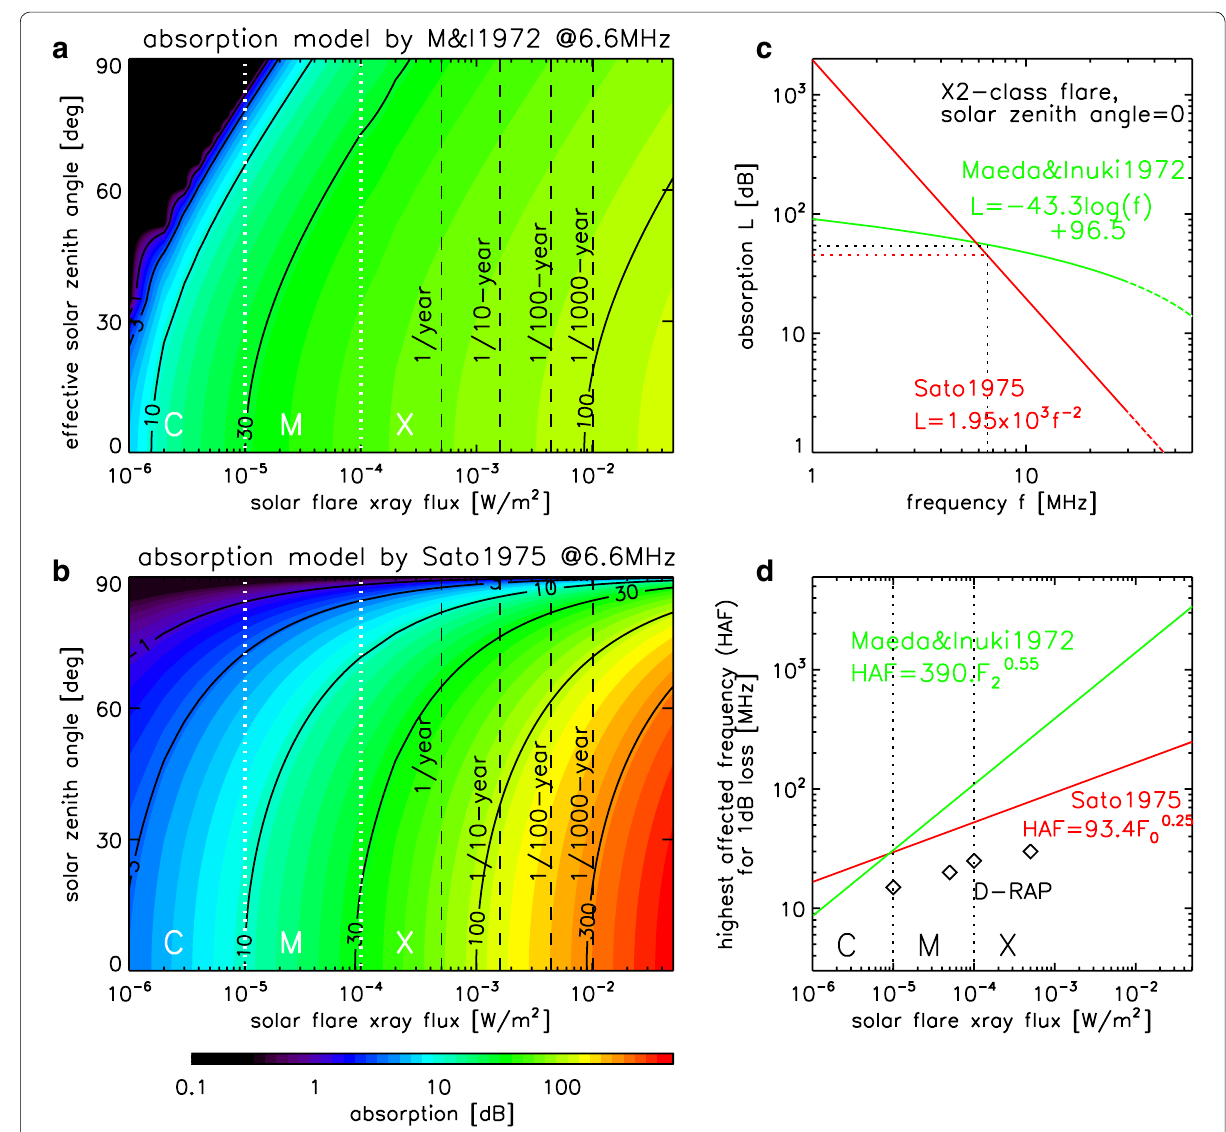
Fig. 9 Absorption intensity in dB at 6.6 MHz as a function of solar flare X-ray flux and (effective) solar zenith angle obtained using a Eq. (10) from Maeda and Inuki (1972) and b Eq. (2) from Sato (1975) with a common color contour shown by the color bar at the bottom, c absorption intensity for X2-class flare and solar zenith angle of 0° as a function of signal frequency, and d highest affected frequency (HAF) as a function of solar flare X-ray flux. In c, d, the absorption intensity from Maeda and Inuki (1972) and that from Sato (1975) (considering the round trip for the HAF) are shown by green and red lines, respectively, and diamonds in d are the HAFs used in